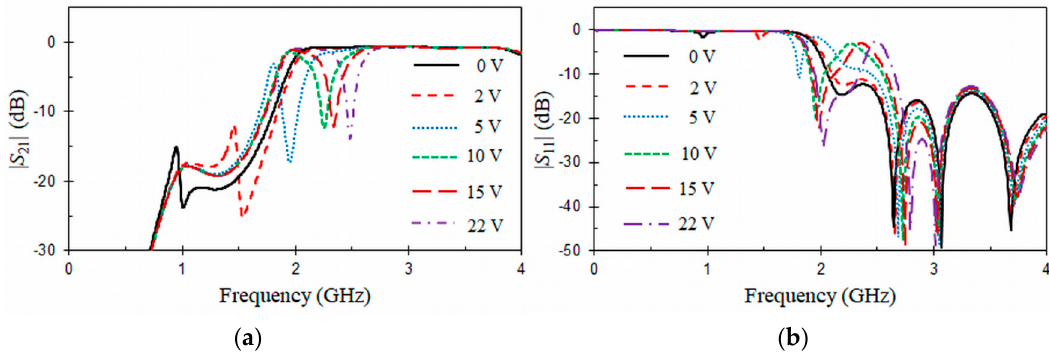
Figure 16. Measured ( a ) | S 21 | (dB) and ( b ) | S 11 | (dB) +of the tunable HMSIW band-stop filter under different DC bias. Table 2. Comparison of different tunable SIW/HMSIW band-stop filters. Refs.